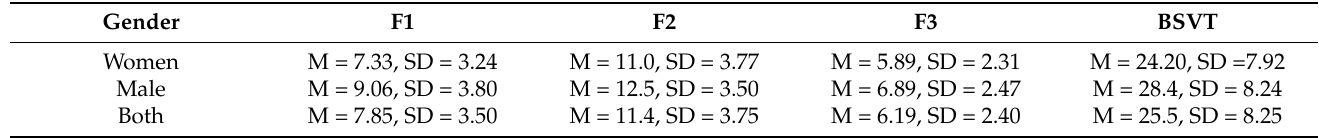
Table 2. Descriptive data of the BSVT-11 by gender and total